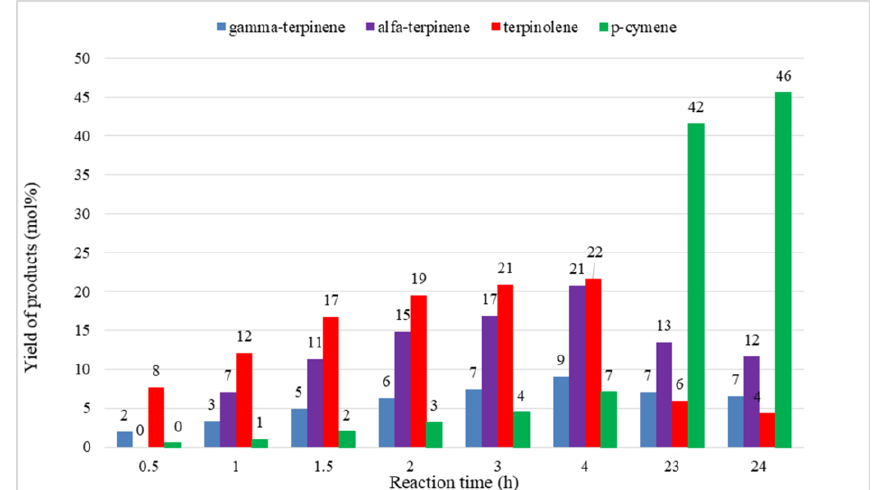
Figure 4. The influence of the reaction time on the yields of products of isomerization of limonene. The amount of the catalyst was 15 wt % and the temperature of the isomerization process was 170 °C.